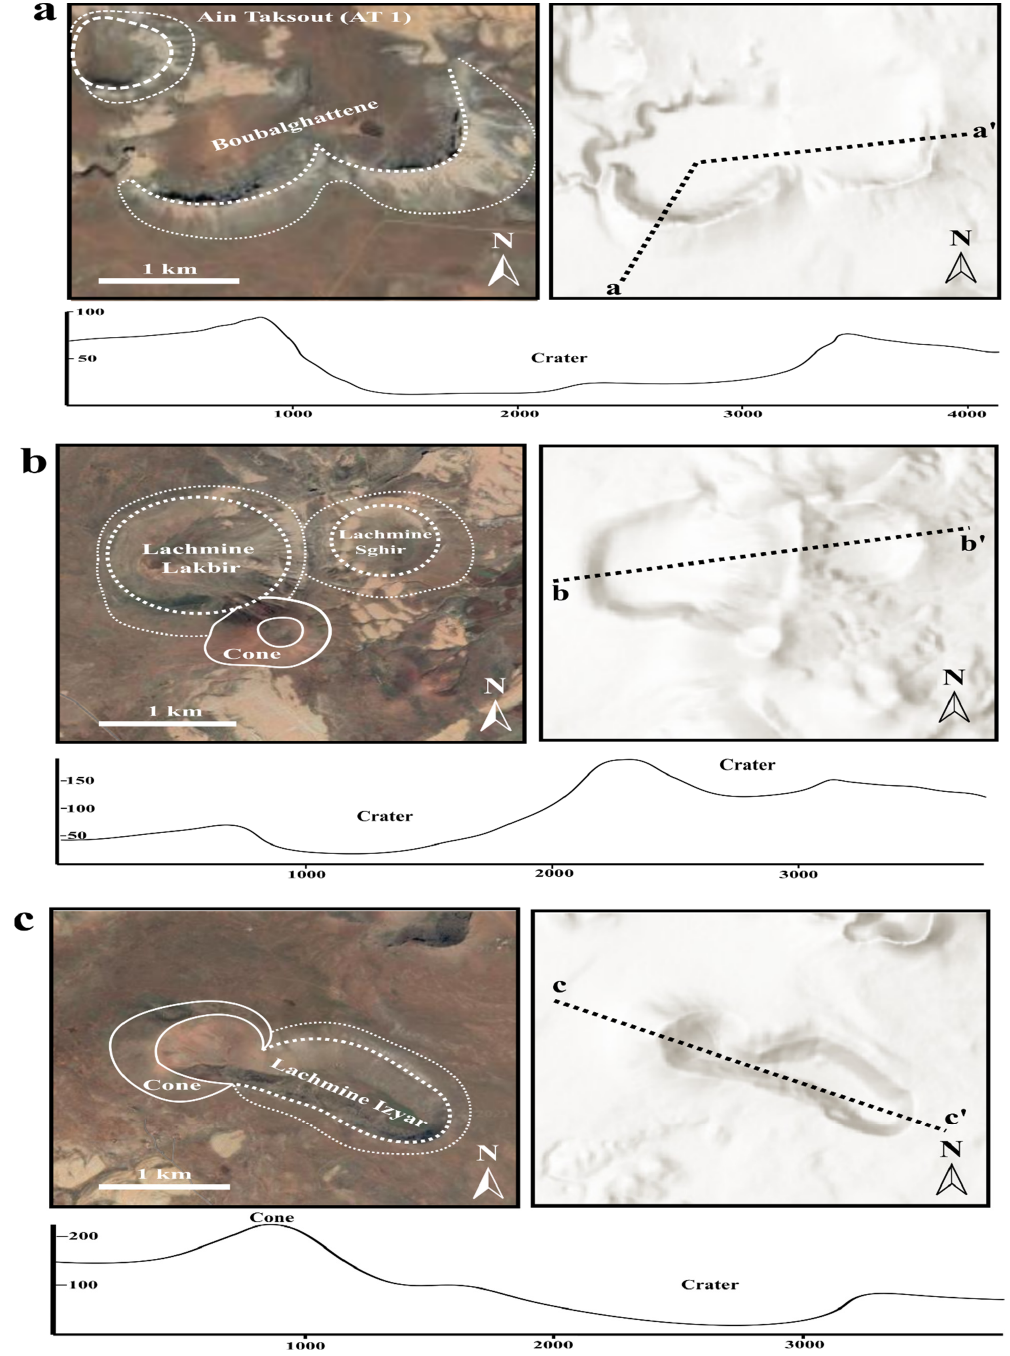
Figure 5. Google Earth satellite photos, digital terrain models, and associated topographic profiles along the dotted lines for maars: ( a ) Boubalghattene (33 ◦ 20 (cid:48) 33 (cid:48)(cid:48) N; 5 ◦ 2 (cid:48) 56 (cid:48)(cid:48) W); ( b ) Lachmine Lakbir et Sghir (33 ◦ 12 (cid:48) 19 (cid:48)(cid:48) N; 5 ◦ 7 (cid:48) 7 (cid:48)(cid:48) W et 33 ◦ 12 (cid:48) 26.312 (cid:48)(cid:48) N; 5 ◦ 6 (cid:48) 15.023 (cid:48)(cid:48) W); ( c ) Lachmine Izyar (33 ◦ 16 (cid:48) 0 (cid:48)(cid:48) N; 5 ◦ 6 (cid:48) 14 (cid:48)(cid:48)